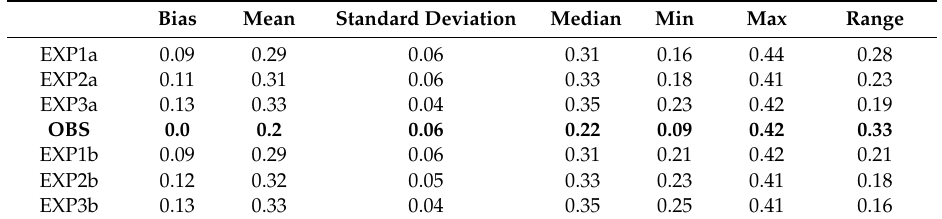
Table 11. Volumetric water content (VWC) (m 3 m − 3 ) (0–10 cm) simulated and observed at the CO station (data number